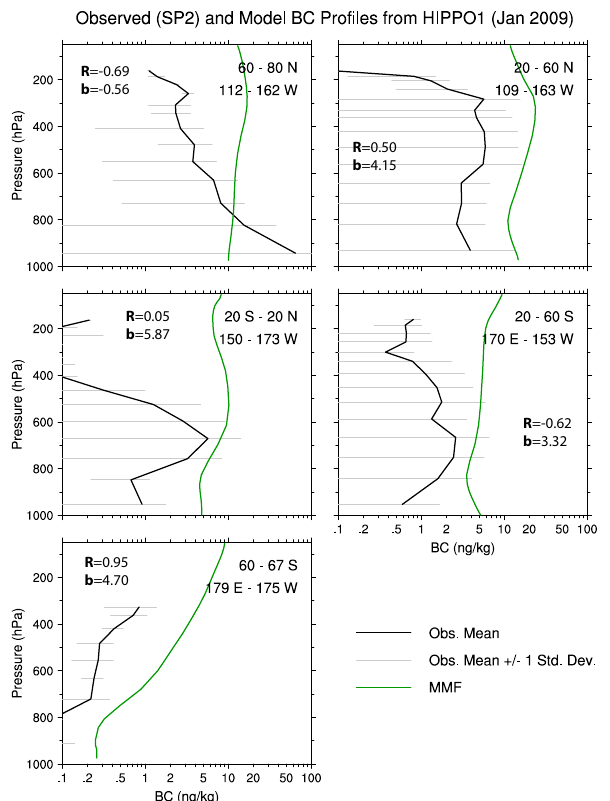
Fig. 17. The same as Fig. 15, but for BC vertical profiles above Figure 17 the remote Pacific from 67 ◦ S to 80 ◦ N during the HIAPER Pole-to- Pole Observations (HIPPO) campaign in January 2009 (Schwartz et al., 2010). The observational data was grouped into five lati- tude zones (67–60 ◦ S, 60–20 ◦ S, 20 ◦ S–20 ◦ N, 20–60 ◦ N, and 60– 80 ◦ N). Monthly mean model profiles are averaged over the obser- vational regions defined by the latitude and longitude boundaries shown in each panel.